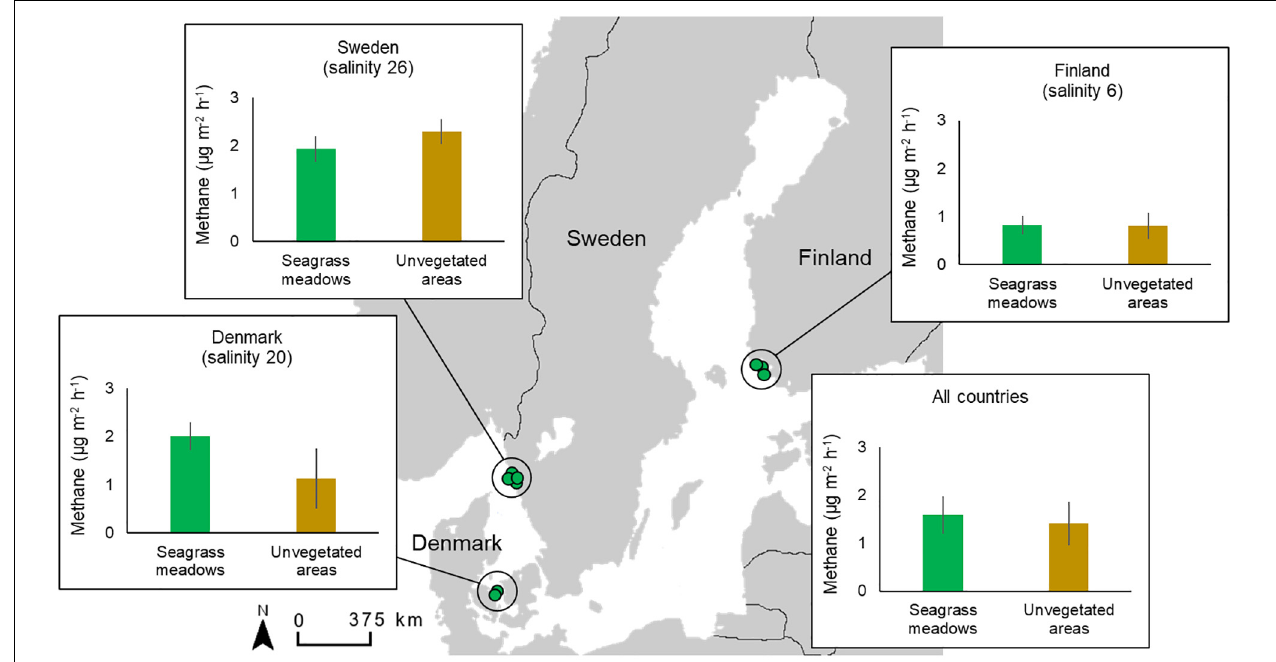
FIGURE 1 | Map of sites (green dots, n = 2–4) in the three sampling regions (countries) with average methane emissions from sediments in seagrass meadows and unvegetated areas in each region as well as overall for all countries.